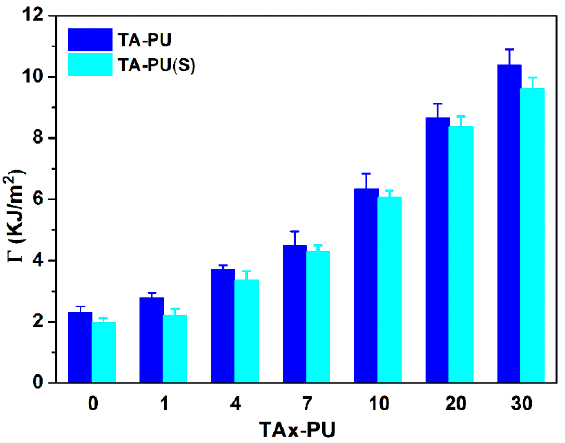
Figure 6. Fracture energy of TAx–PU hydrogels at as-prepared and equilibrium swelling states.